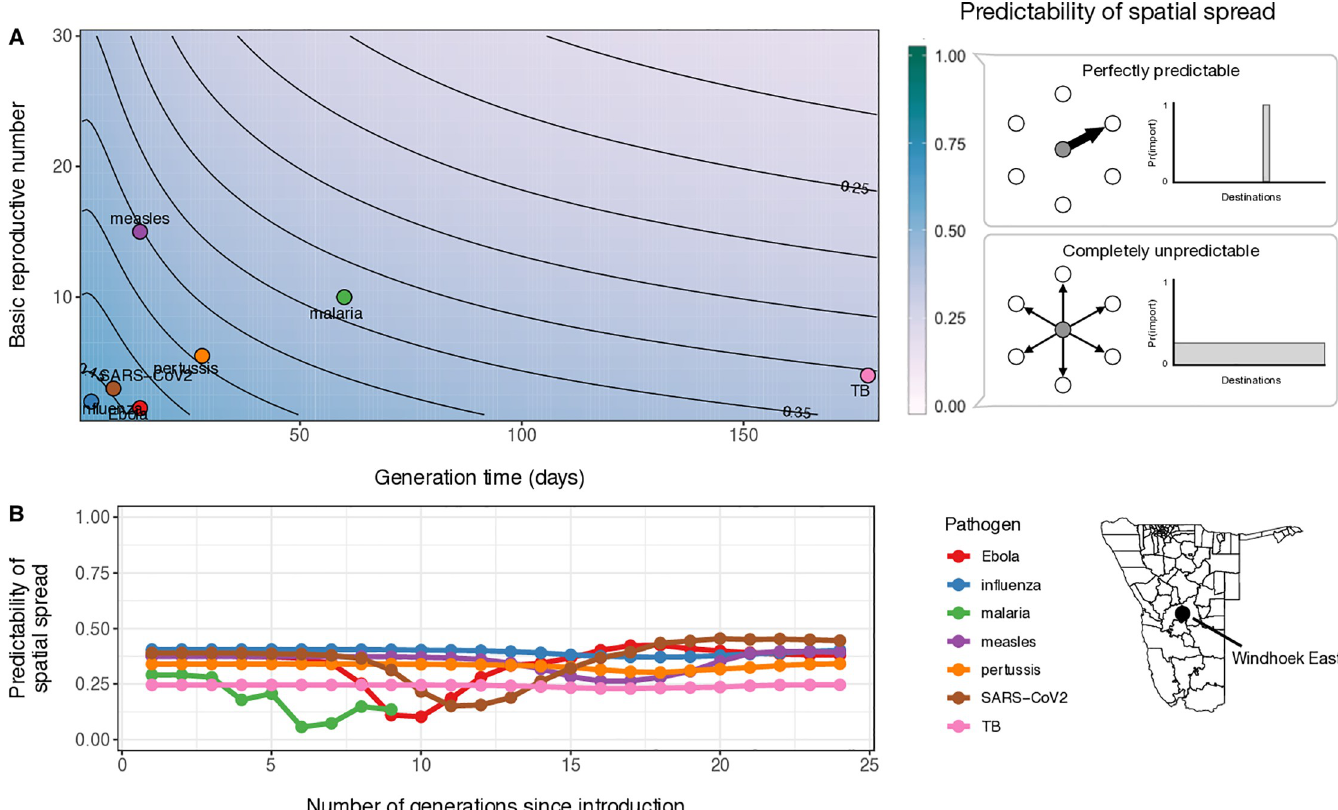
Fig 6. Predictability of spatial spread for a range of R 0 and generation time values and the change in spatial predictability over time for 7 pathogens. A) A heatmap with contour lines showing the values of initial spatial predictability ( ϕ ) calculated for hypothetical combinations of R 0 and generation time (days). Example pathogens are indicated by colored circles: influenza, SARS-CoV-2, measles, Ebola, pertussis, P . falciparum malaria, tuberculosis. The level of spatial predictability is shown in the color bar to the right with schematic representations for scenarios where patterns of spatial spread are perfectly predictable ( ϕ = 1) or completely unpredictable ( ϕ = 0). B) The change in these initial values of spatial predictability over successive generations for each of the 7 example pathogens. Colored lines represent the mean value of spatial predictability calculated over 1000 replicates of the stochastic TSIR model (see Methods). In both analyses, the capital district of Namibia, Windhoek East, was used as the introduction